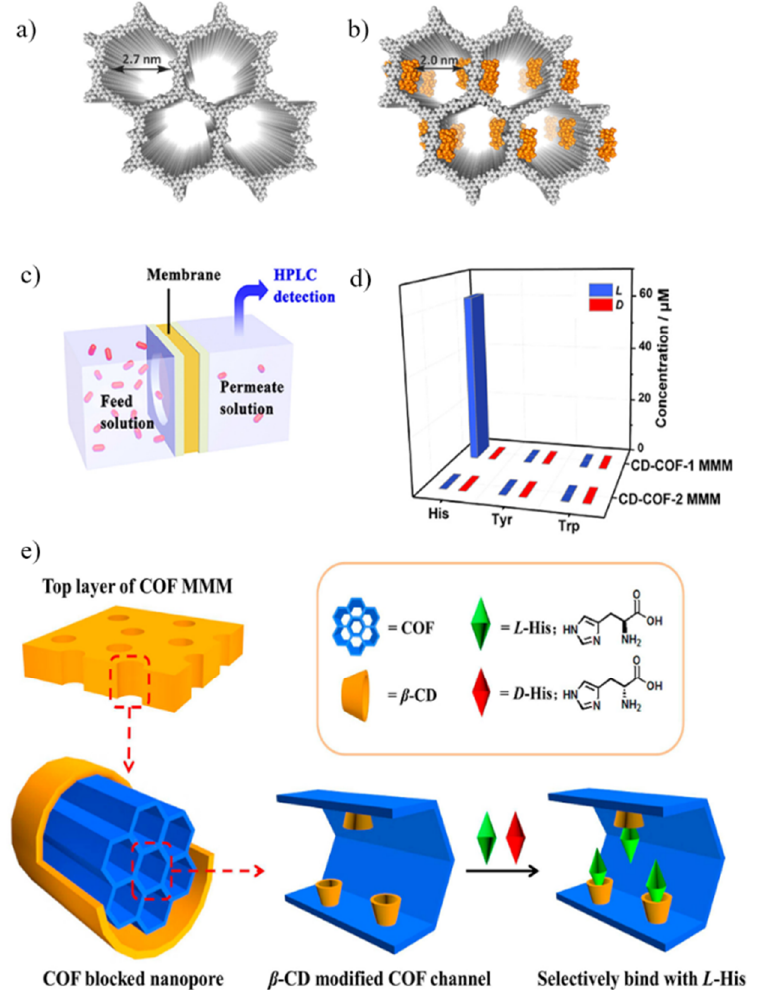
Figure 4. ( a ) Top view of covalent organic framework–1 (COF–1). ( b ) Chemically modified COF-1 with β–cyclodextrin (β–CD). ( c ) Scheme of penetrating amino acids via membrane. ( d ) Concentration of permeate solution after transporting. ( e ) Schematic illustration of chiral CD–COF MMM system. Reproduced with permission from [74] Copyright 2019 American Chemical Society